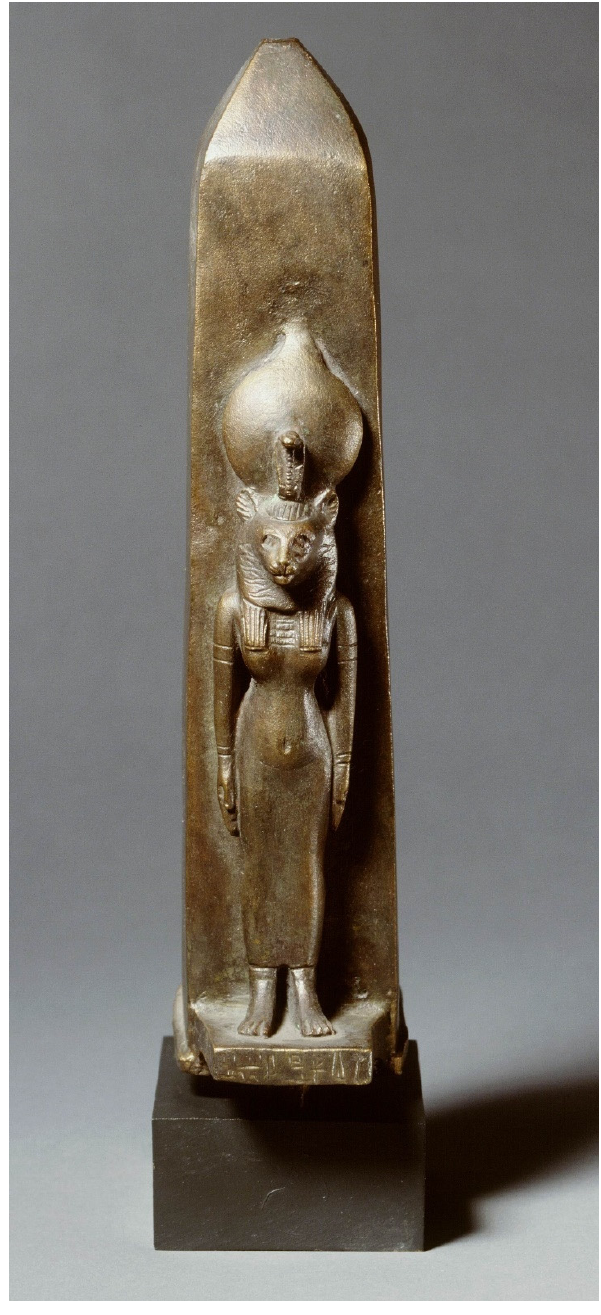
Figure 3. Α bronze reliquary for an ichneumon inscribed for the Egyptian goddess Wadjet. Leiden, Rijksmuseum van Oudheden F 1953/5.2. den, Rijksmuseum van Oudheden F 1953/5.2. (https://www.rmo.nl/collectie/collectiezoeker/collectiestuk/?object=13099, on 24